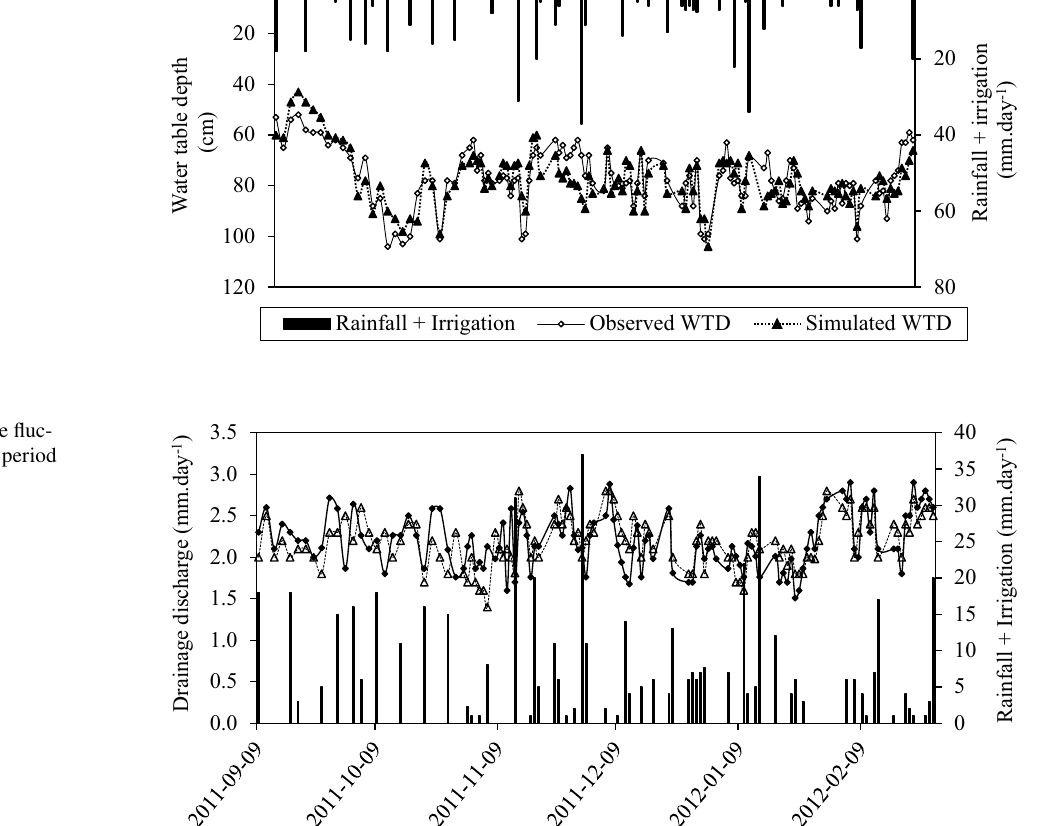
Fig. 6 Water table depth fluc- tuation during validation period